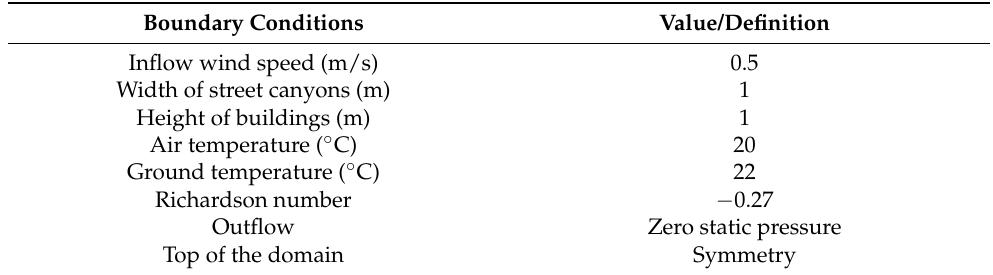
Table 1. Boundary conditions for validation